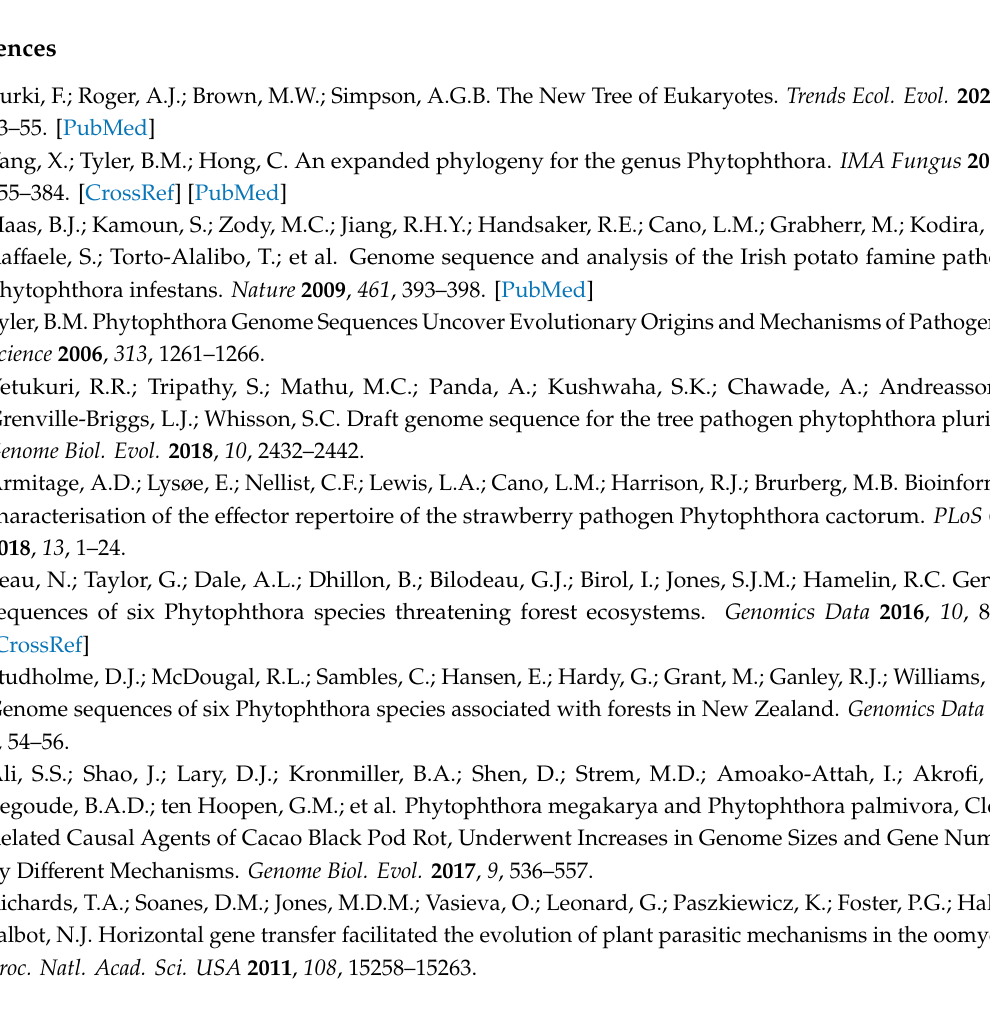
Table S1: List of oomycete genomes used in this study, Table S2: Repetitive element annotation, Table S3: Functional annotation of gene models, Table S4: Annotation of mitochondrial genes, Table S5: Annotation of RxLR e ff ectors, Table S6: Annotation of CAZymes using dbCAN2, Table S7: List of clusters of tandemly duplicated genes, Table S8: List of identified extracellular protein groups, Table S9: List of identified mycelial protein groups, Figure S1: Nucleotide alignment of Phytophthora mitochondrial genomes, Figure S2: Distribution of CAZyme families across 44 oomycete